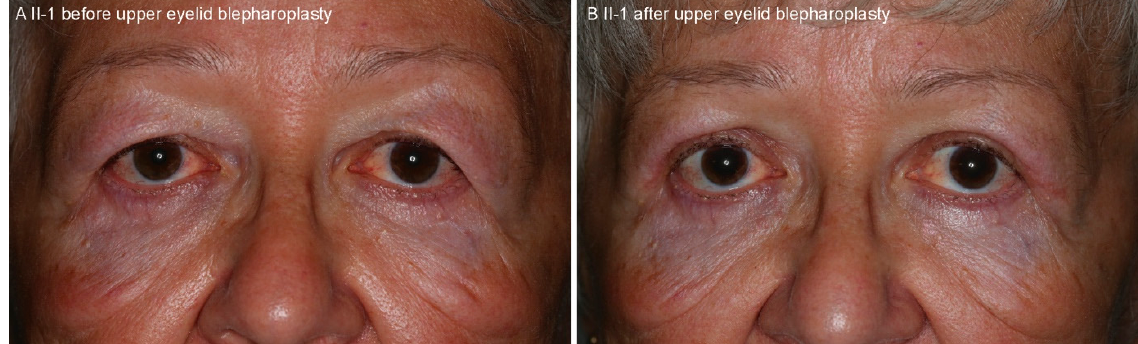
Figure 3. The facial appearance of the patient II-1 before ( A ) and after ( B ) the upper eyelid blepharoplasty. Note the loose skin (cutis laxa) of the upper and lower eyelids, characteristic for gelsolin amyloidosis. skin (cutis laxa) of the upper and lower eyelids, characteristic for gelsolin